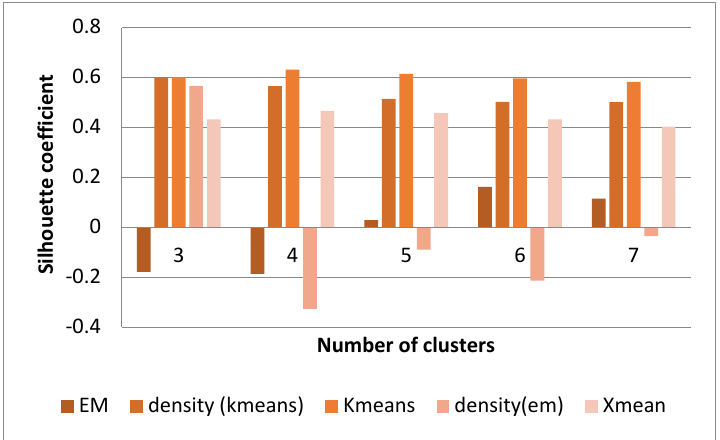
Figure 15. Silhouette coefficient value of different clustering methods–long call scenario.